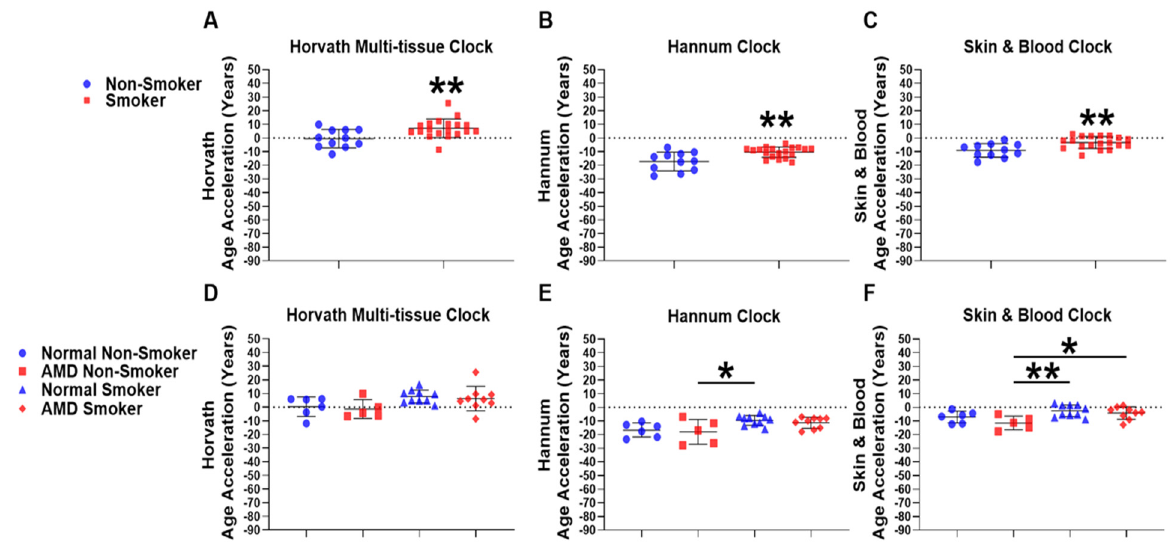
Figure 3. Epigenetic age acceleration is associated with smoking but not AMD in whole blood. EAA analysis was conducted using DNAm microarray data to compare differences from Smoker ( n = 19) and Non-Smoker ( n = 11) whole blood gDNA using the ( A ) Horvath multi-tissue, ( B ) Hannum and, ( C ) Skin & Blood epigenetic clocks. EAA analysis was further stratified to compare differences amongst the following four groups: Normal Non-Smoker ( n = 6); AMD Non-Smoker ( n = 5); Normal Smoker ( n = 10); AMD Smoker ( n = 9) using ( D ) Horvath’s multi-tissue, ( E ) Hannum’s and ( F ) the Skin & Blood epigenetic clocks. Smokers displayed a significant increase in EAA using ( A ) Horvath’s multi-tissue clock ( p = 0.0071), ( B ) Hannum’s clock ( p = 0.0014), and ( C ) the Skin & Blood clock ( p = 0.0025) when compared to Non-Smoker groups. Following stratification into four separate groups, no significant differences were observed following one-way ANOVA when analysing ( D ) Horvath’s multi-tissue epigenetic clock, but were identified using the ( E ) Hannum and ( F ) Skin & Blood epigenetic clocks (Supplementary Materials: Additional File S2, Table S5). Following application of the TukeyHSD post-hoc test, no significant differences were identified when comparing Normal Non-Smoker and AMD Non-Smoker, in addition to Normal Smoker and AMD Smoker groups using the ( E ) Hannum and ( F ) Skin & Blood epigenetic clocks. Significant differences were identified when comparing EAA between AMD Non-Smokers and Normal Smokers using the ( E ) Han- num and ( F ) Skin & Blood epigenetic clocks. When comparing AMD Non-Smoker and AMD Smoker groups, no significant difference was found when comparing the ( E ) Hannum epigenetic clock, however a significant increase in EAA was found using the ( F ) Skin & Blood epigenetic clock (for individual p -values, see Supplementary Materials: Additional File S2,